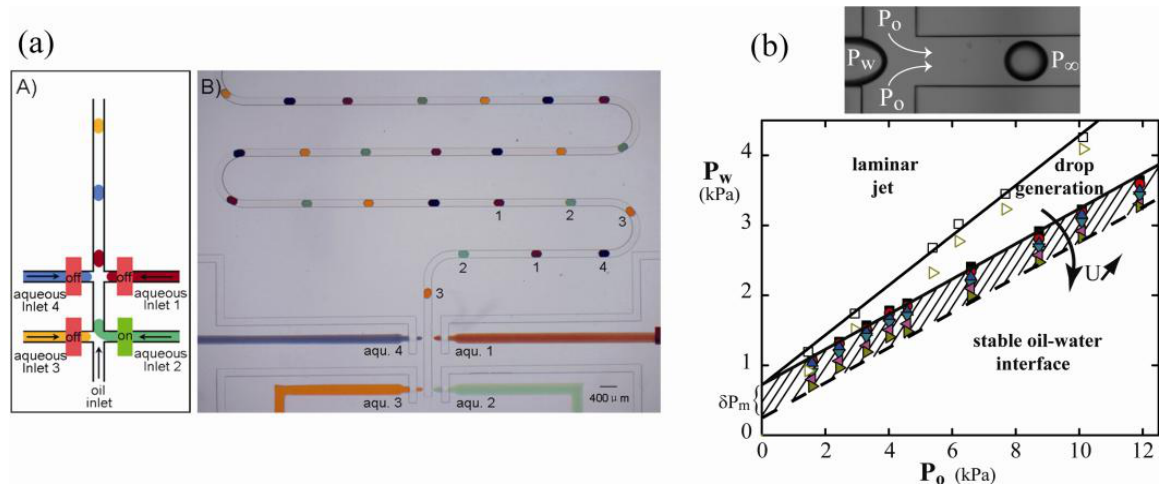
Figure 10. ( a ) On-demand formation of arrays of droplets with distinct composition by sequentially switching on/off microvalves. Reprinted from [82] with permission from the Royal Society of Chemistry; ( b ) Phase diagram for EW induced droplet formation. In the hatched area, droplets can be formed on demand. Reprinted from [83] with permission from IOP